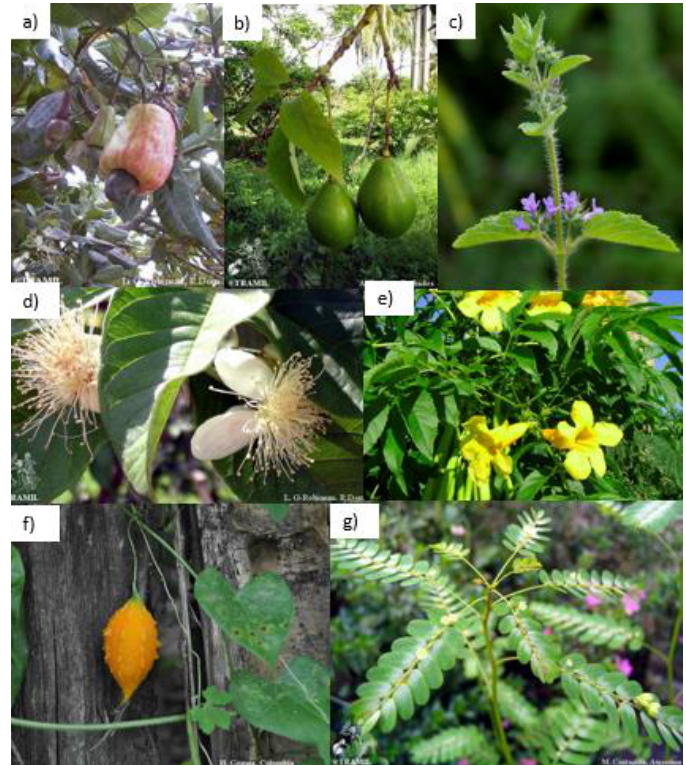
Figure 1. Representative picture of medicinal Caribbean flora discussed through the review. ( a ) Anacardium occidentale L., ( b ) Hyptis suaveolens (L.) Poit., ( c ) Persea americana Mill., ( d ) Psidium guajava L., ( e ) Tecoma stans (L.) Juss. ex Kunth, ( f ) Momordica charantia L. and ( g ) Phyllanthus niruri L. (source: www.tramil.net).